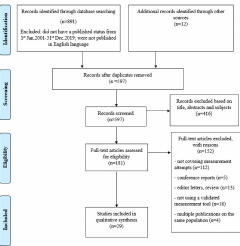
Figure 1. Preferred reporting items for systematic reviews and meta-analysis flow